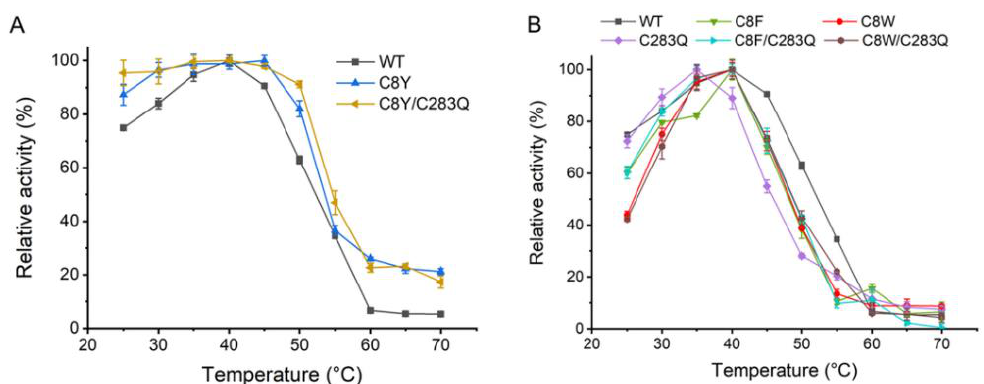
Figure 3. Optimum temperature of mutants C8Y and C8Y/C283Q ( A ) and optimum temperature of mutants C8F, C8W, C283Q, C8F/C283Q, and C8W/C283Q ( B ). The activity at optimum temperature of each enzyme was set as 100%, respectively. Table 3. Specific activities and kinetic parameters of AsA and its mutants.